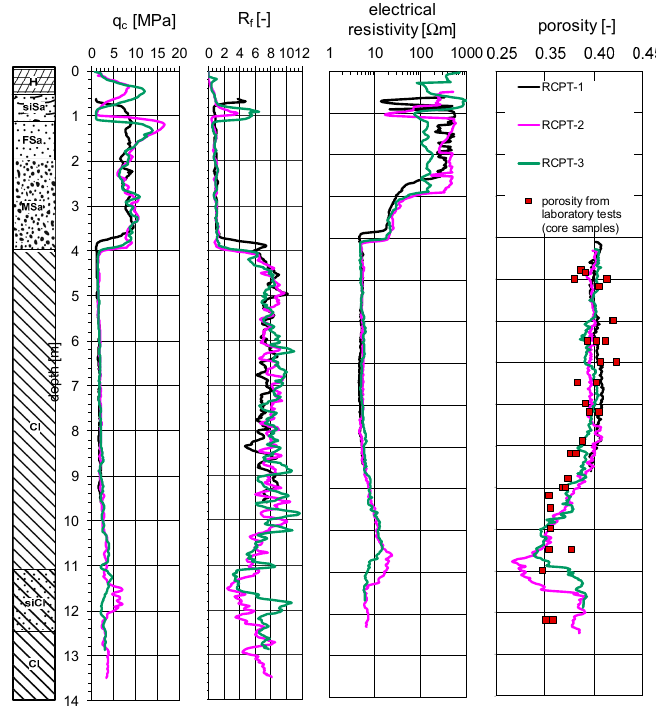
Figure 10. Results of RCPT tests; q c —cone resistance, R f —friction ratio, electrical conductivity and porosity of clays.